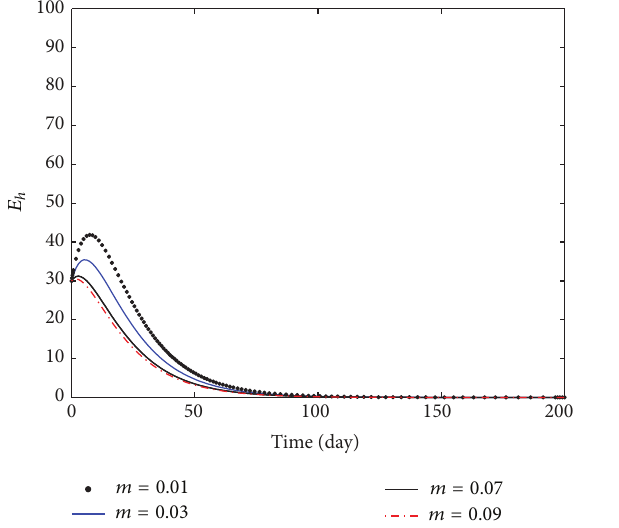
Figure 3: Plot of the case infected vector